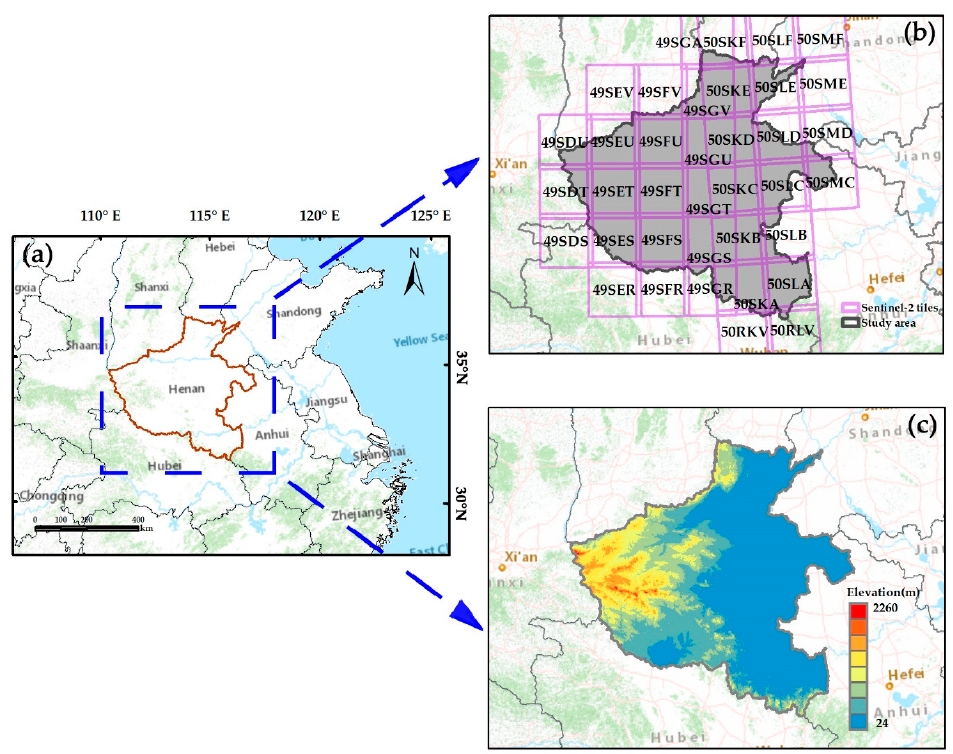
Figure 1. Location of Henan province ( a ). Sentinel 2 satellite utilizes Universal Transverse Mercator (UTM) projection and follows the US-MGRS (U.S. Military Grid Reference System) to set the satellite orbit number ( b ). The number of images covering the study area ranges from (49SD~50SM) to (50RK~50SL), with a total of 37 images. The lowest elevation in Henan province is 24 m, and the highest elevation is 2260 m ( c ).